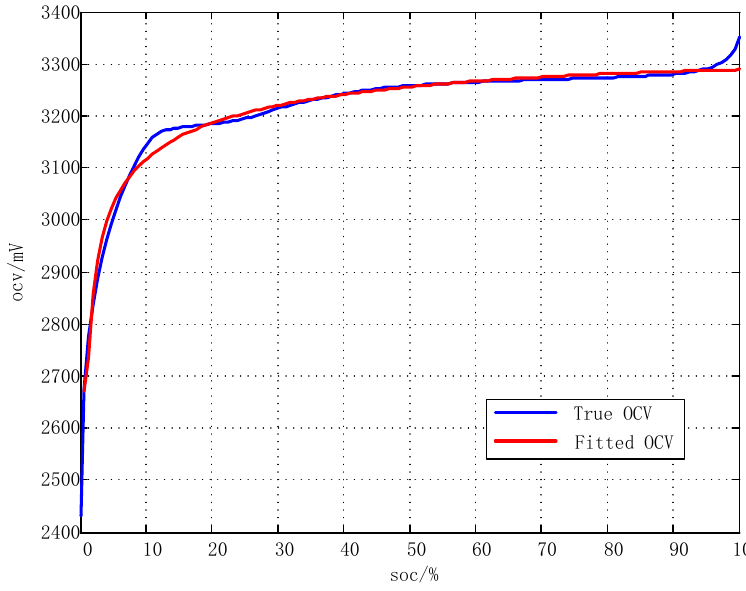
Figure 6. SOC-OCV curve and its